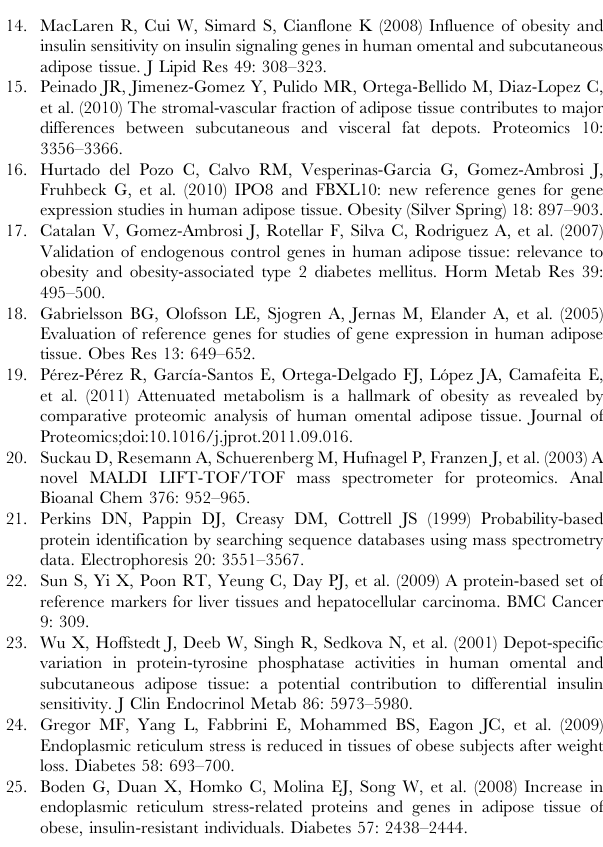
Figure S1 Protein expression levels in omental adipose tissue from non-obese and non-diabetic, and type 2 diabetic obese subjects. Representative Western Blot analysis of ENOA, PARK7, FAA, Beta-actin, GAPDH, TBB5 and CALX expression in omental fat samples from non-obese and non- diabetic (control), and type 2 diabetic obese subjects. ENOA, PARK7 and Beta-actin proteins show steady expression profiles across samples with CV of 13%, 20% and 28% repectively. Relative intensity values from band densitometry are expressed as mean 6 SD.